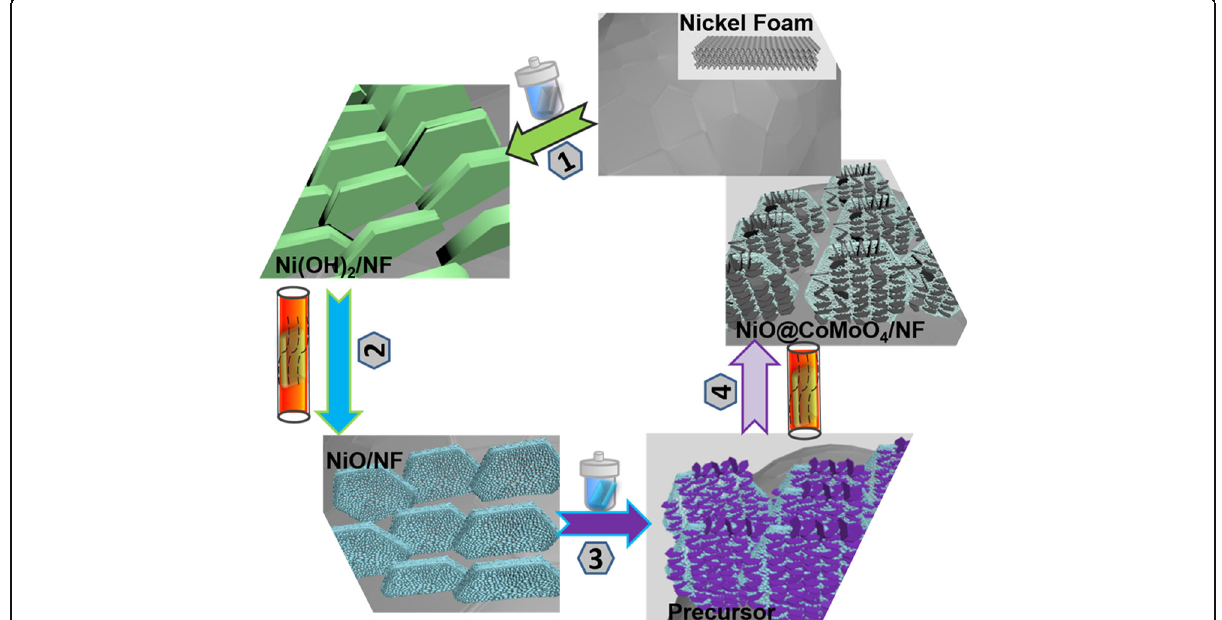
Fig. 1 The synthesis illustration of NiO flakes@CoMoO 4 NSs